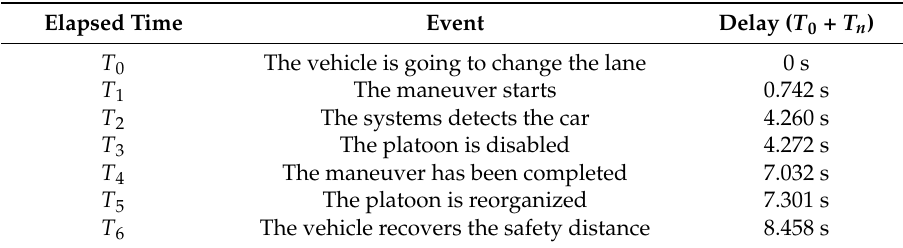
Table 3. Results of the cut-in maneuver tests.